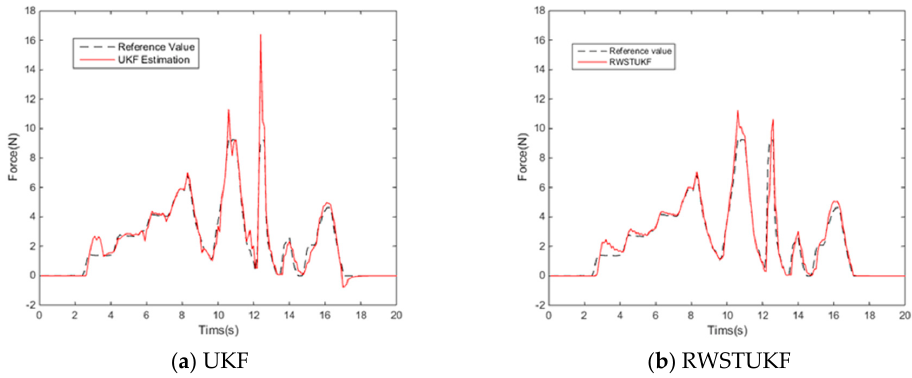
Figure 6. Reconstructed forces via both UKF and RWSTUKF for robotic indentation. Table 4. Estimation errors of both UKF and RWSTUKF for robotic indentation.